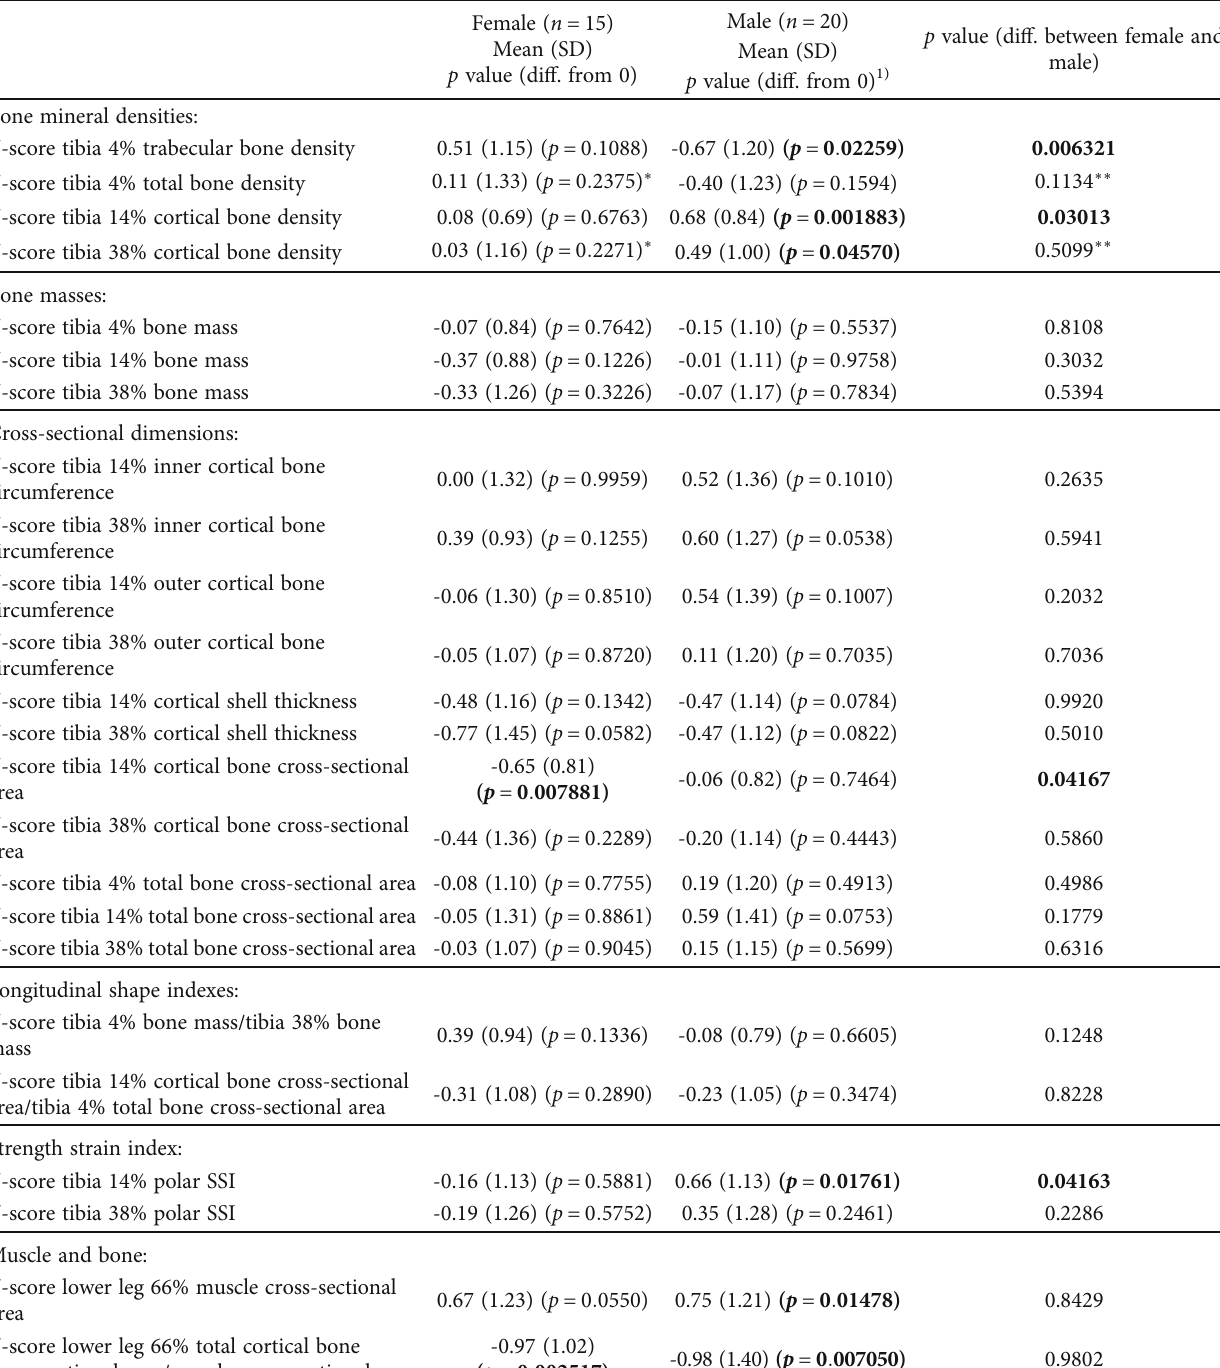
Table 3: Peripheral quantitative computed tomography Z -scores in comparison with hypothetical mean zero by sex.